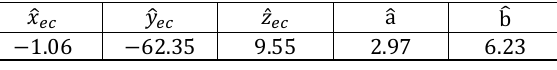
Figure 4. Standard deviations of representative points on